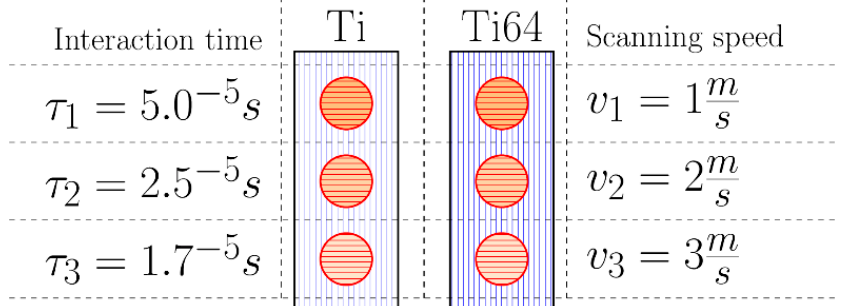
Figure 2. ( a ) Cold spray equipment, ( b ) 3D metal printer AYAS-200 used for laser surface treat- ment.